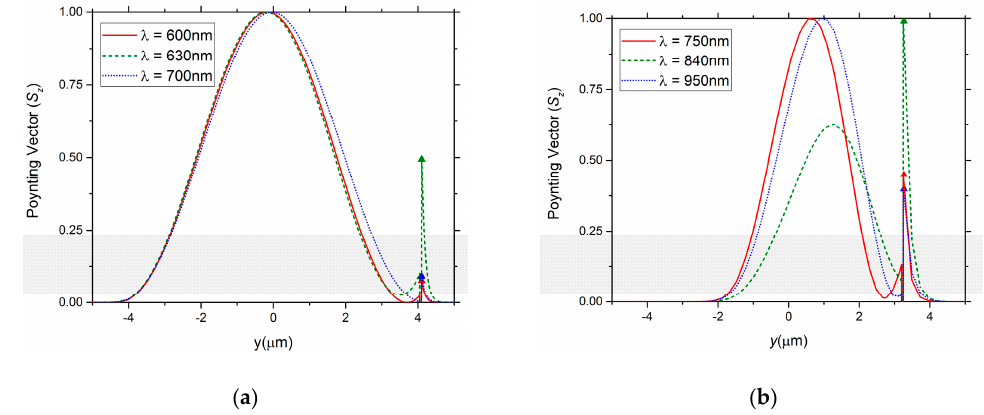
Figure 3. Normalized Poynting vector amplitude 1D across the fiber core: ( a ) for conventional D-type fiber structure and ( b ) for PCF D-type fiber structure ( n ext = 1.39).